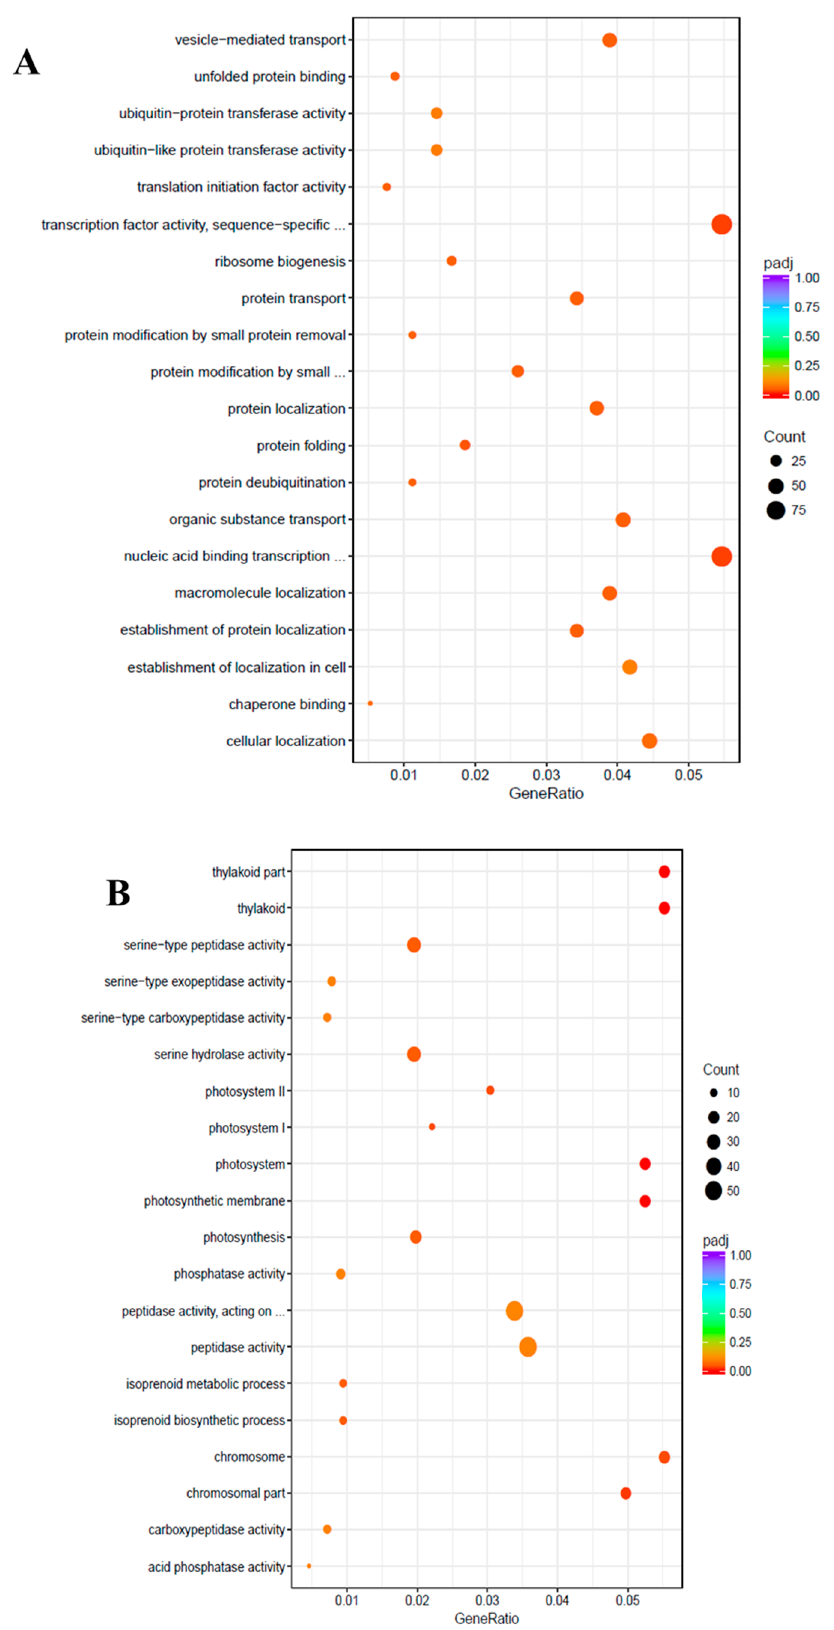
Figure 4. Gene Ontology (GO) enrichment scatter plot. The GO enrichment analysis showing the top 20 enriched functions for up-regulated ( A ) and down-regulated ( B ) DEGs. The horizontal axis is GeneRatio (the ratio between the number of differentially expressed genes in each GO term, and all